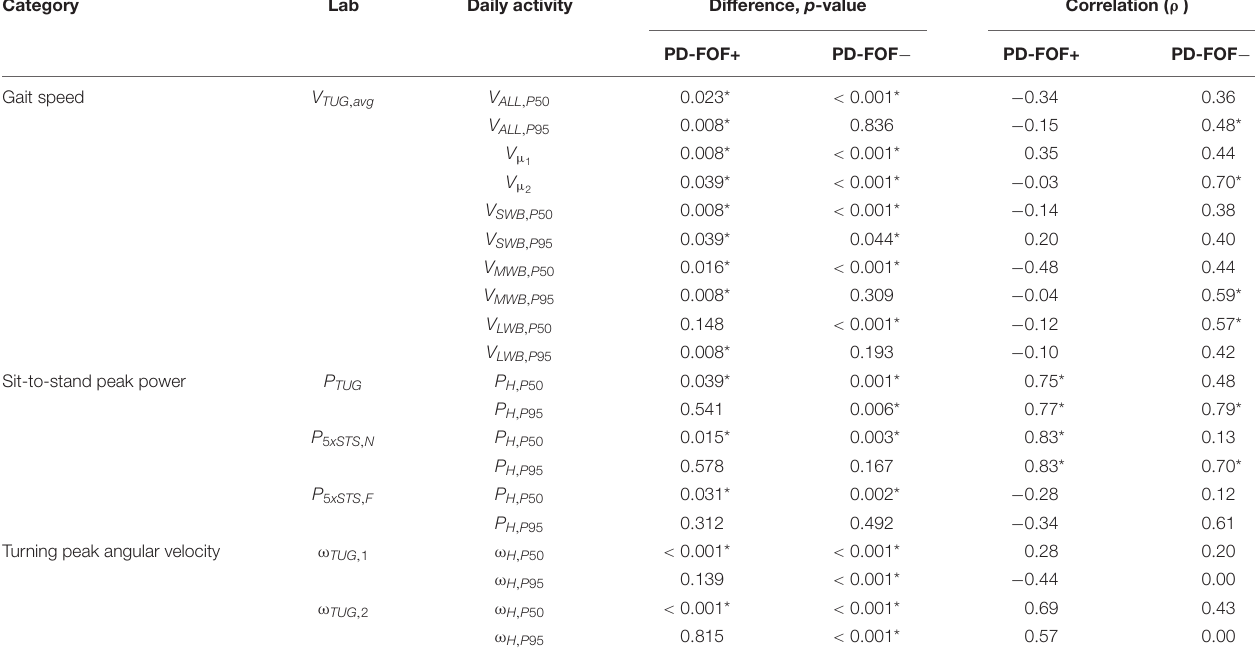
TABLE 5 | Paired comparison of the parameters between lab and home. Category